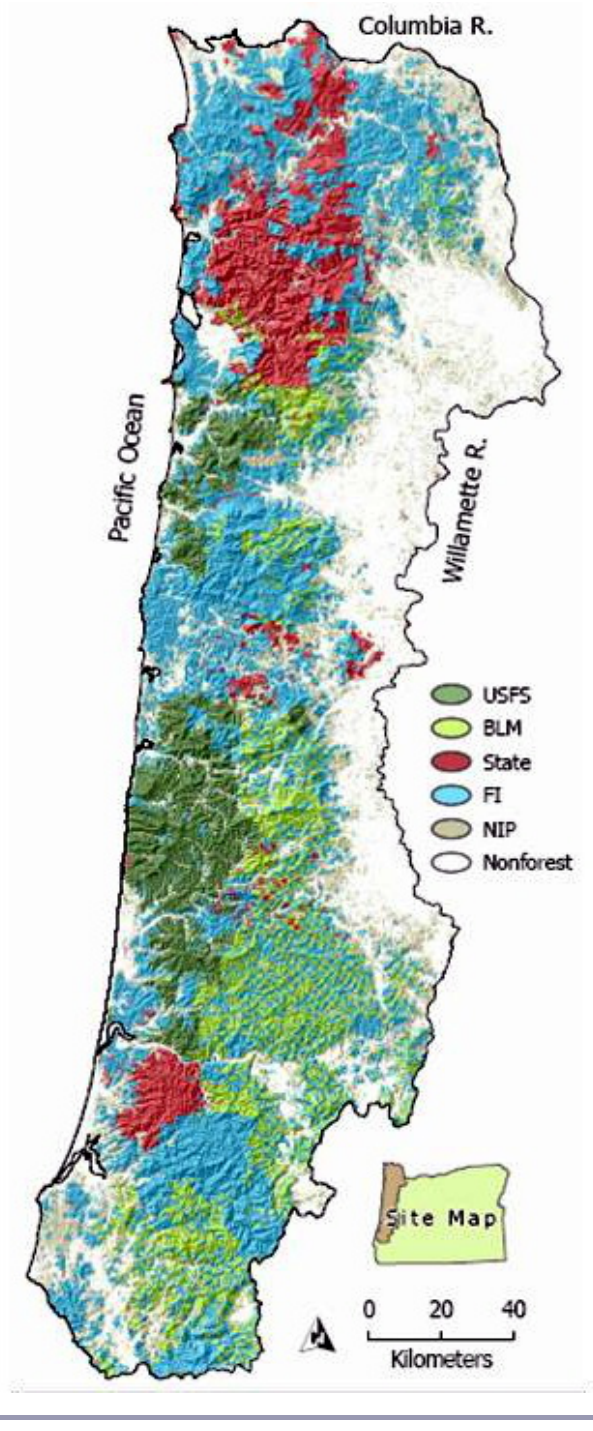
Fig. 1. Patterns of land ownership in the Oregon Coast